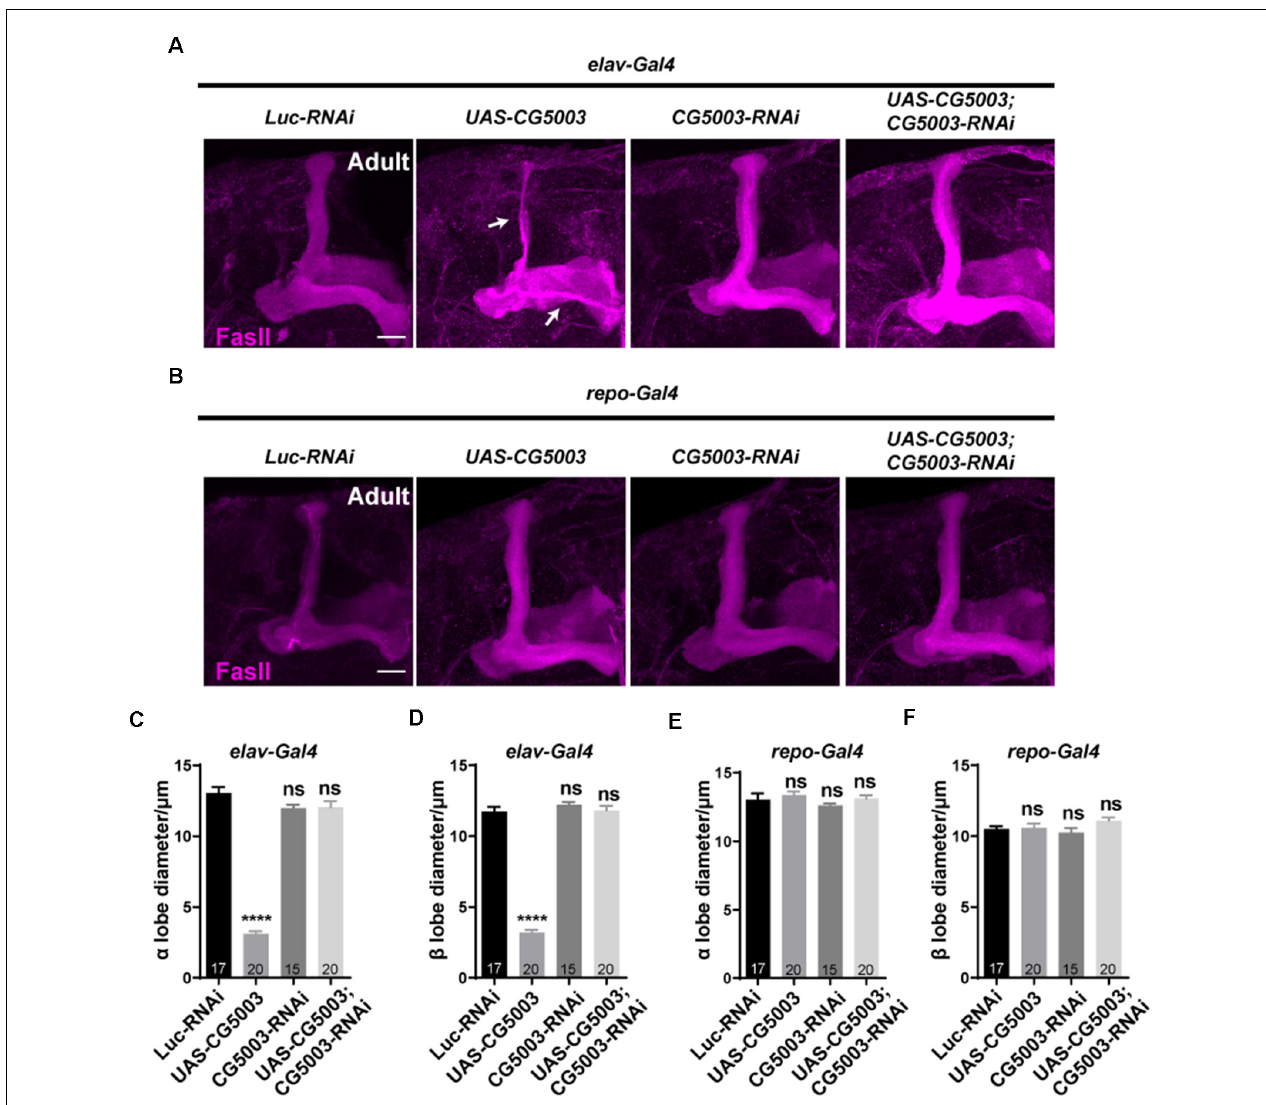
FIGURE 4 | Pan-neuronal CG5003 expression causes MB α / β lobe defects. (A–F) Representative confocal images (A,B) and quantifications (C–F) of MB α / β lobe formation of control and experimental fly brains at the adult stage. Note that FasII-positive α / β lobes are severely disrupted when CG5003 is expressed in all neurons. White arrows indicate the thinned α / β lobes. The N number of brains dissected and quantified for each genotype is indicated in the figure. Scale bar: 50 µ m. ns, not significant; **** p <